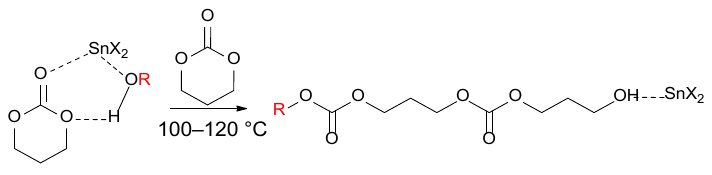
Figure 4. Coordination‐insertion mechanism in the presence of alcohol [30].